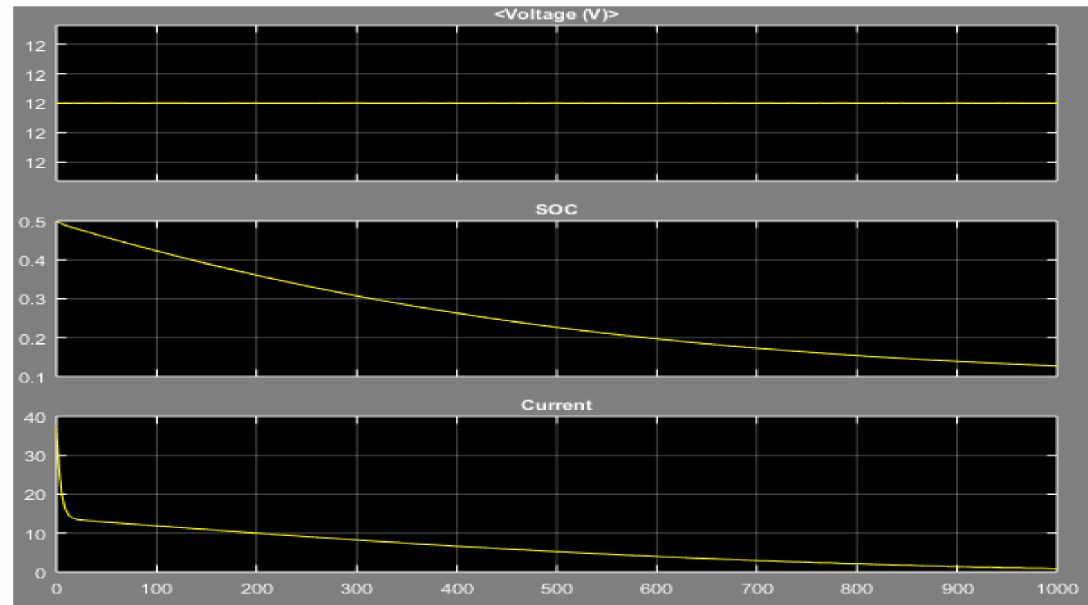
Figure 14. The discharging characteristics of the battery (Note: SOC-State of